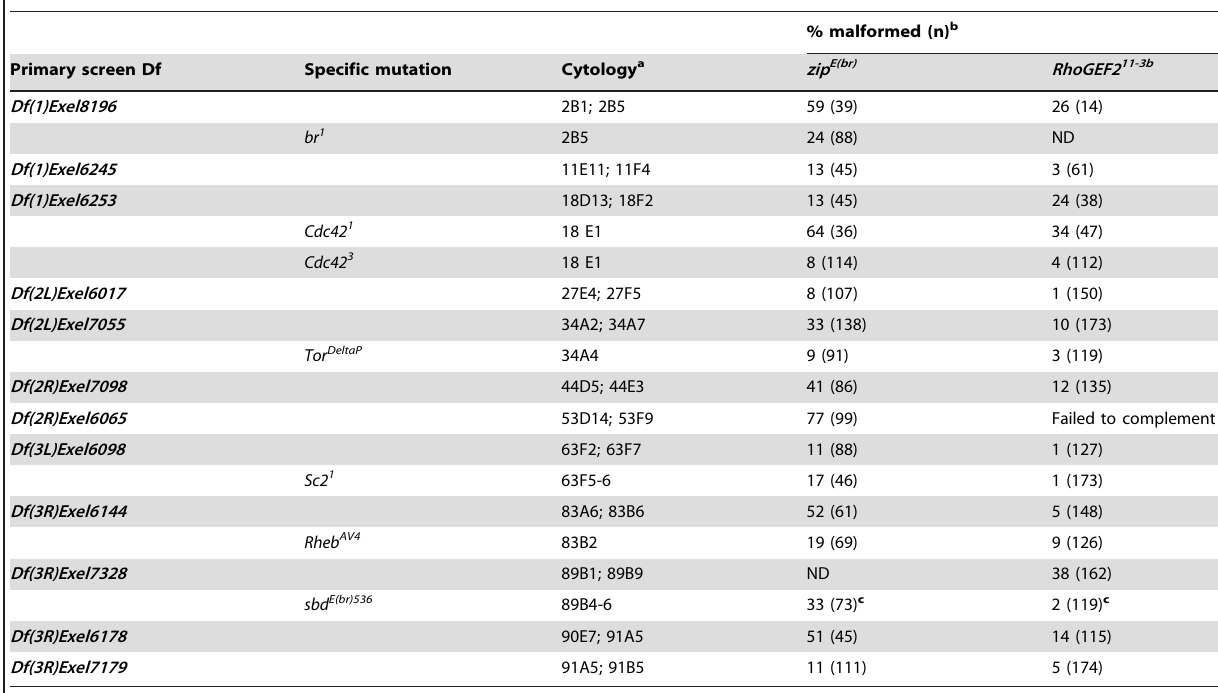
Table 3. SSNC tests between Rho1 -interacting deficiencies and zip and